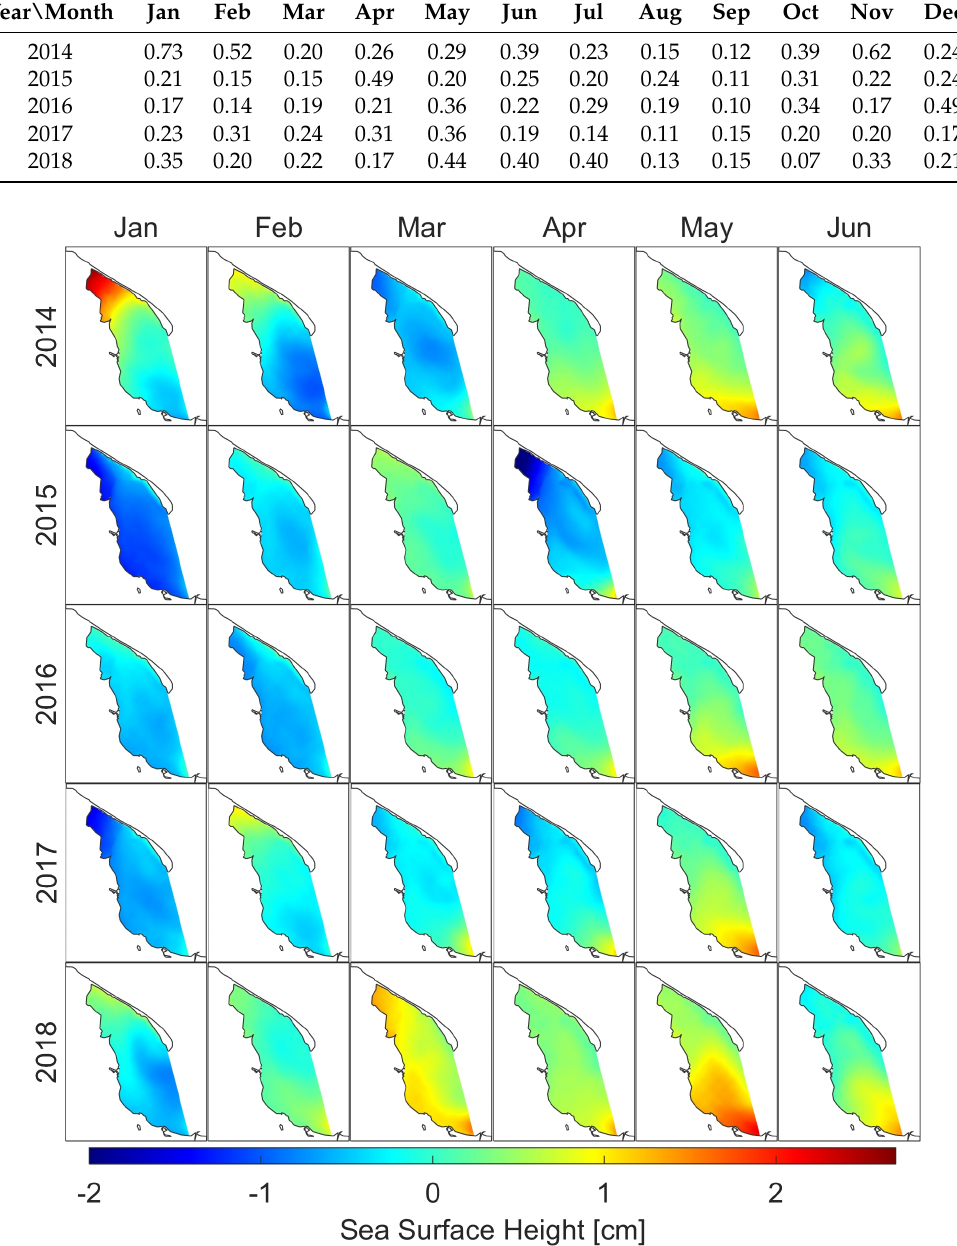
Figure A19. Monthly means of sea surface height for separated years. January to